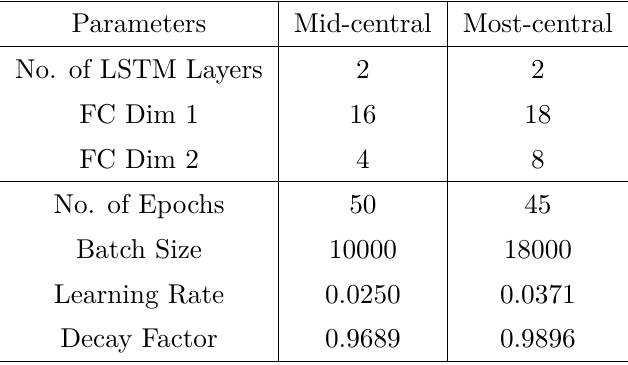
Table 2 . List of hyper-parameters related to the neural network architecture and the training process, and their optimal values after